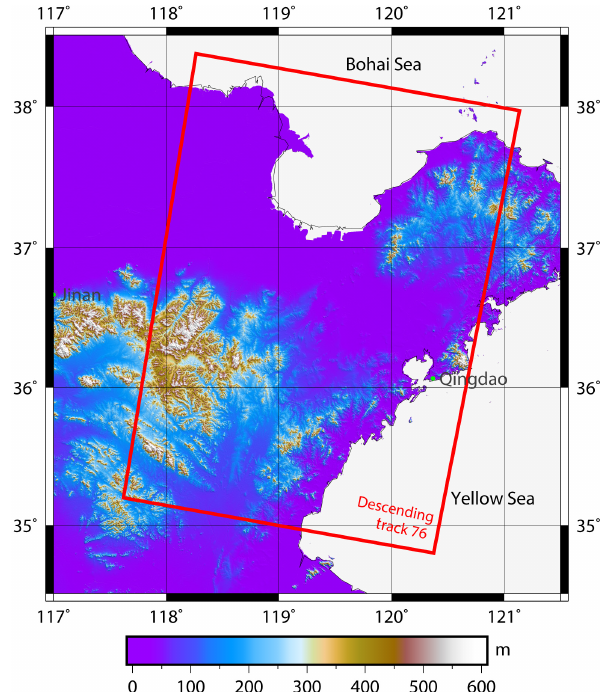
Figure 2. Overview of the study area with topography as the back- ground